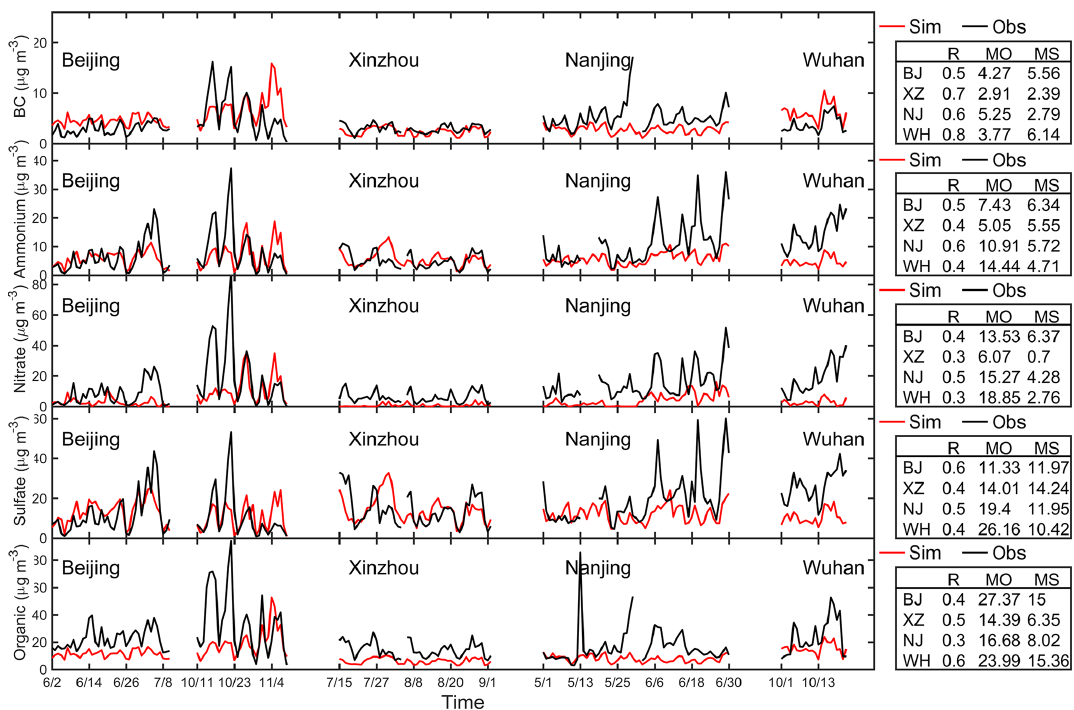
Figure 16. Daily variation of aerosol components (µgm − 3 ) over China. The black and red lines represent the daily mean concentration of the city-averaged observations and simulation respectively. BJ, XZ, NJ, and WH refer to Beijing, Xinzhou, Nanjing, and Wuhan respectively. R , MO, and MM stand for correlation coefficient, mean concentration of observation, and mean concentration of model respectively. (“Organic” on the y axis of the lower panel refers to organic